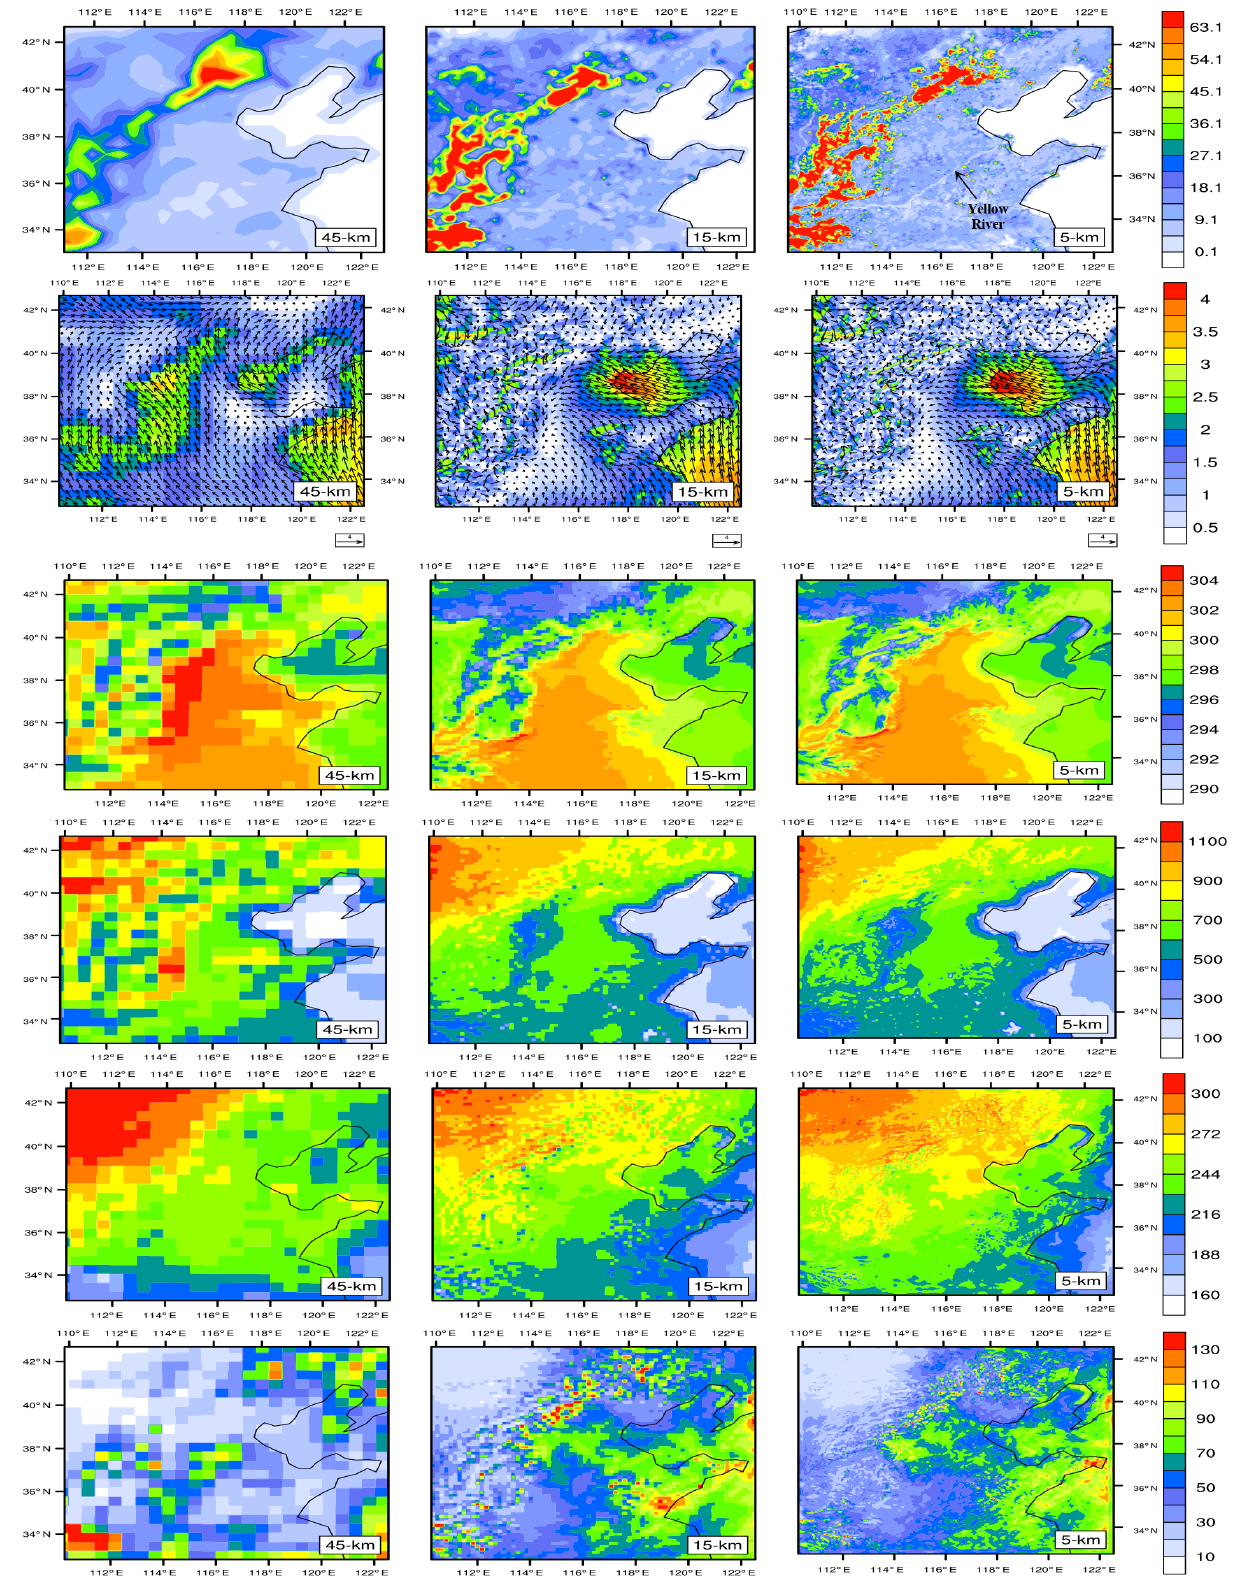
Figure 6. Simulated emissions and July average meteorology from the three grids: first row is isoprene emissions (molkm − 2 h − 1 ) from biogenic sources on a typical summer day; second row is surface wind vector with the shading representing wind speed (ms − 1 ); third row is surface air temperature (K); fourth row is PBLH (m); fifth row is SWDOWN (Wm − 2 ); sixth row is CWP (gm − 2